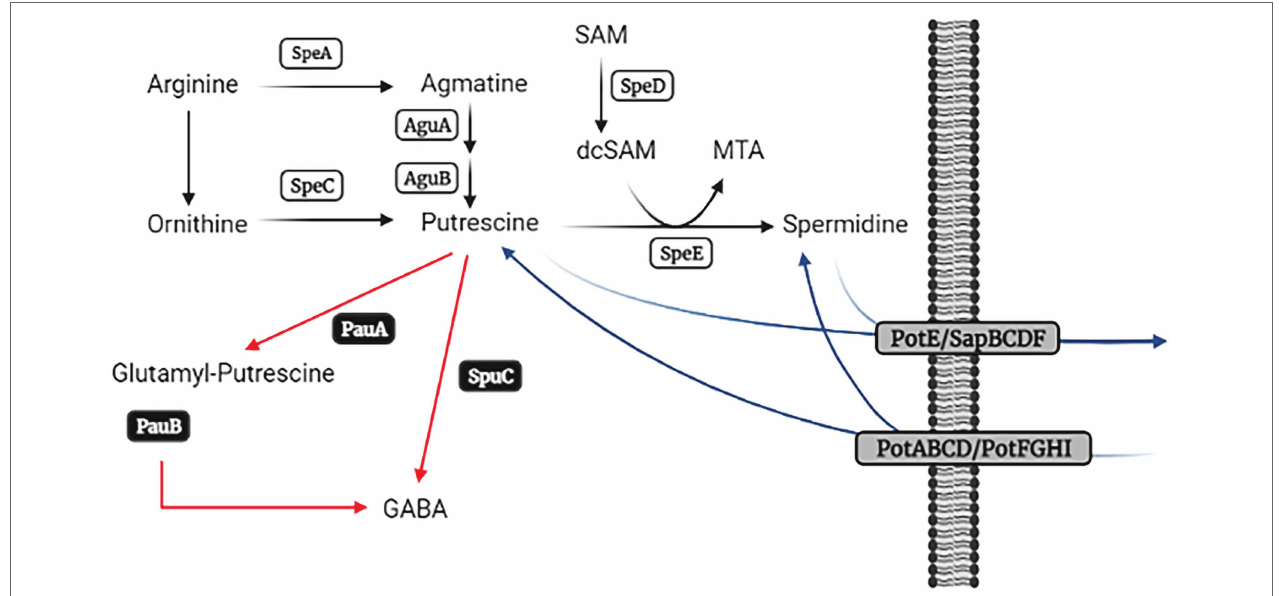
FIGURE 1 | Schematic representation of polyamine metabolism pathways. Biosynthetic enzymes are represented in white rectangles, while black and grey rectangles depict the enzymes involved in polyamine catabolism and transport, respectively. Adapted from Schneider and Wendisch (2011) and created with